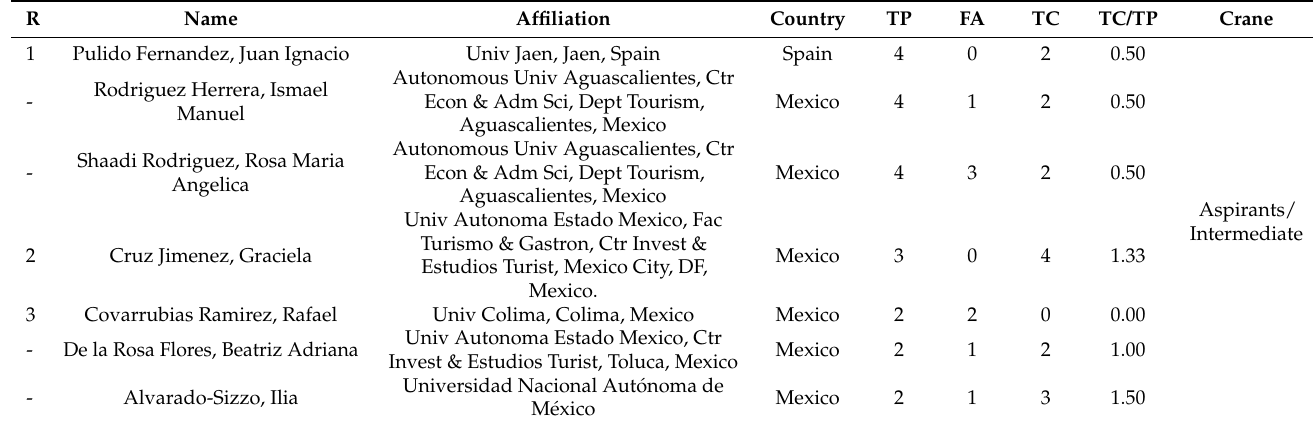
Table 4. Ranking of the most productive authors.